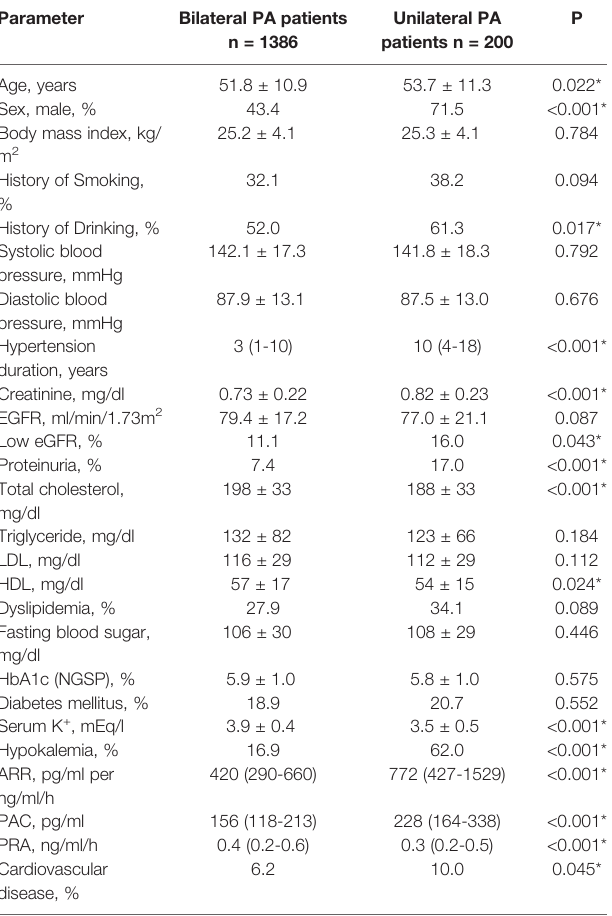
TABLE 1 | Backgrounds and clinical complications of patients with bilateral and unilateral PA without apparent adrenal tumors.